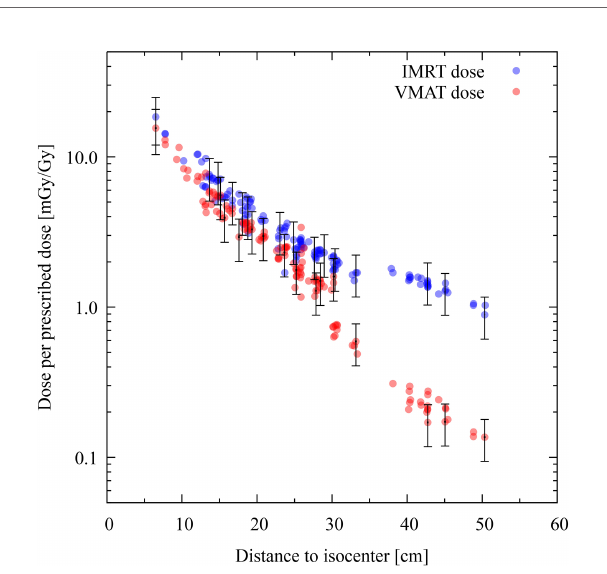
FIGURE 7 | Comparison of intensity-modulated radiotherapy (IMRT) and volumetric modulated arc therapy (VMAT) for experimental data. Each colored dot represents one thermoluminescent dosimeter (TLD) position. The distance of the TLD position to the isocenter (in centimeters) is given on the abscissas, while the ordinates show the dose per prescribed dose (mGy/Gy) in logarithmic scale. The dose distribution for IMRT is shown with blue dots and VMAT with red dots. Statistical uncertainties ( k = 1) are plotted for every twentieth TLD